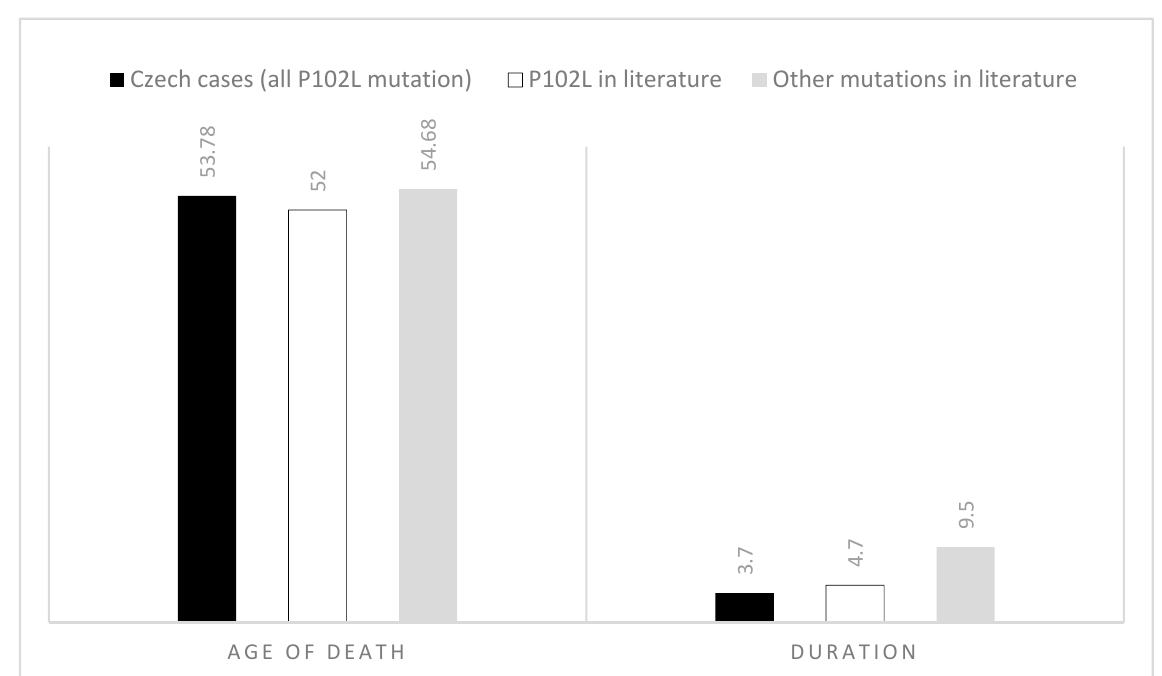
Scheme 1. Comparison of age of death and disease duration in the cohort of Czech cases (all having P102L mutation in PRNP gene), cases with P102L mutation in PRNP from the literature, and all other mutations recorded in the literature.